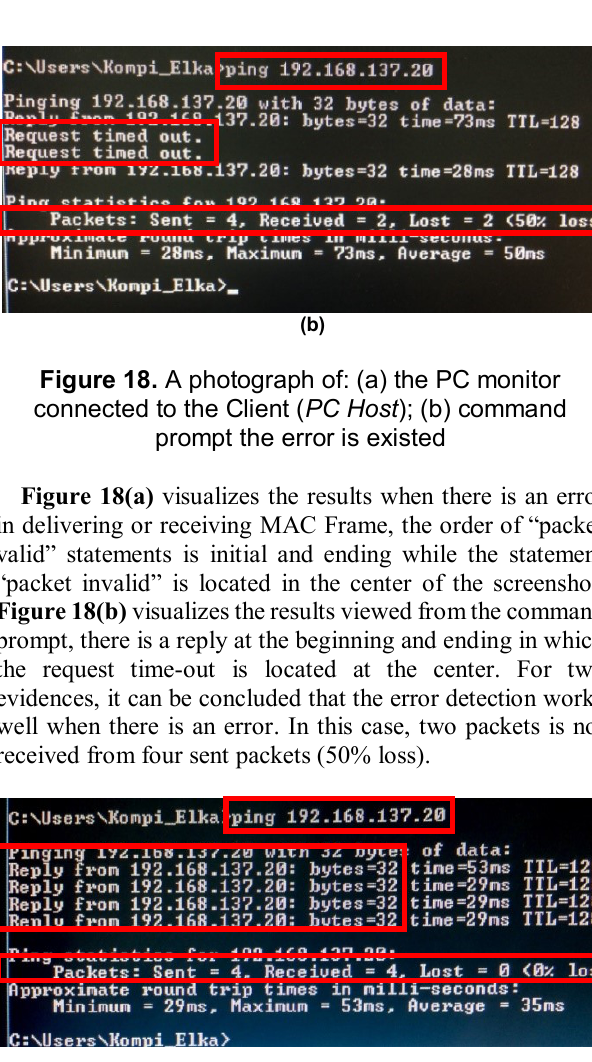
Figure 19. A photograph of command prompt when there is not error occur